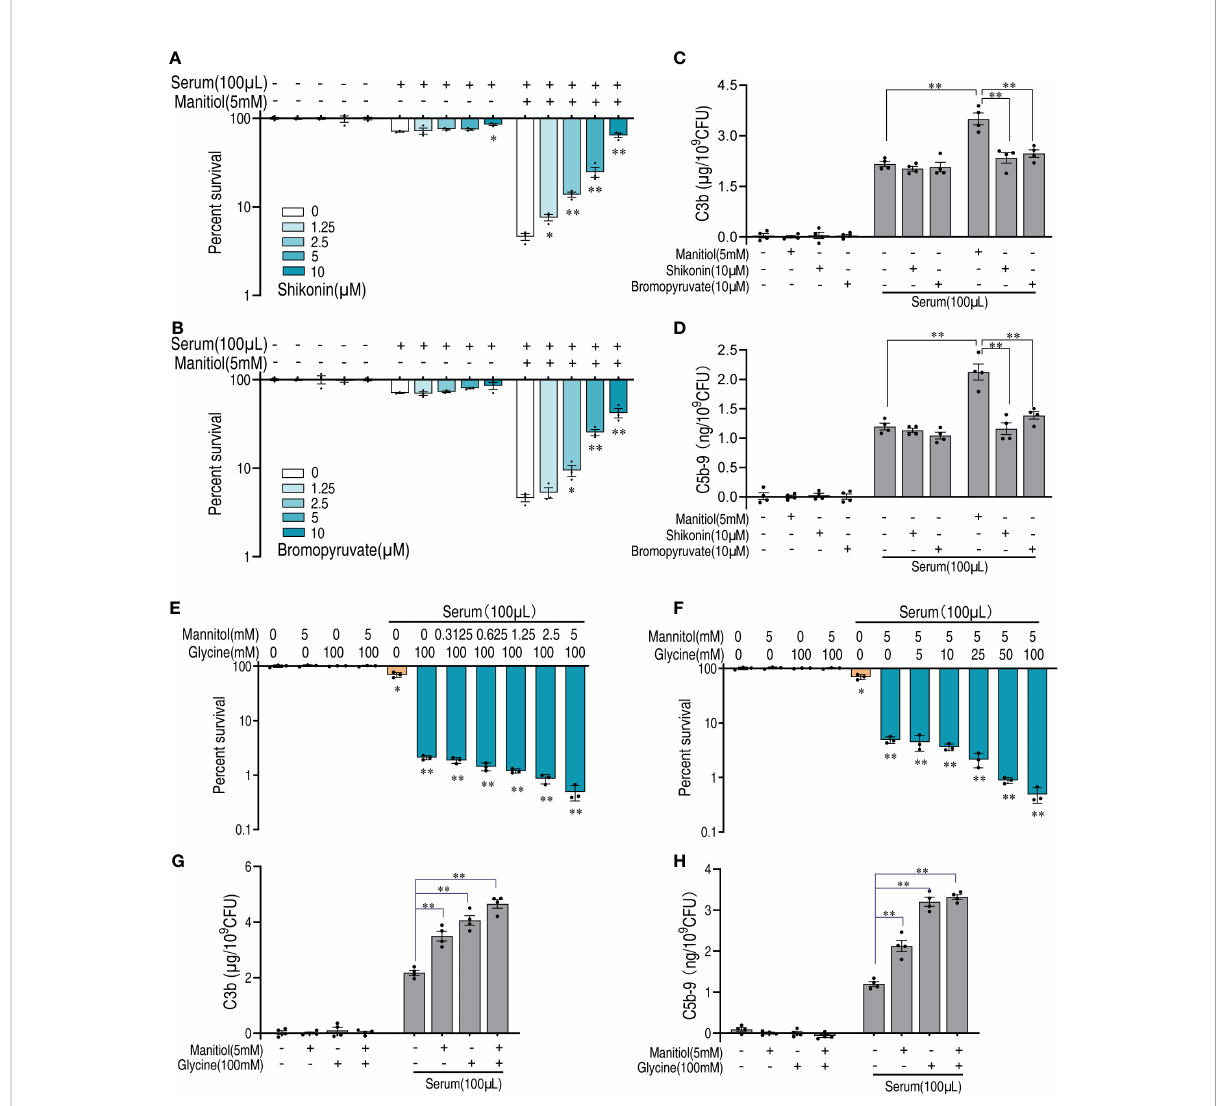
FIGURE 7 Mannitol increases serum sensitivity via glycolysis and the pyruvate cycle. (A, B) Percent survival of V. alginolyticus in the presence or absence of increasing doses of shikonin (A) or bromopyruvate (B) and in the presence of serum and/or mannitol. (C, D) Quanti fi cation of C3b (C) and C5b-9 (D) incubated with 10 m M shikonin or 10 m M bromopyruvate in the presence or absence of 100 m l serum alone or in the presence of or without mannitol (5 mM). (E) Percent survival of V. alginolyticus 12G01 incubated with 100 mM glycine plus serum (100 m l) in a mannitol dose-dependent manner (0 – 5 mM). (F) Percent survival of V. alginolyticus 12G01 incubated with 5 mM mannitol plus serum (100 m l) in a glycine dose-dependent manner (0 – 100 mM). (G, H) Quanti fi cation of C3b (G) and C5b-9 (H) incubated with 5 mM mannitol and/or 100 mM glycine in the presence or absence of 100 m l serum. The results are displayed as means ± SEM, and signi fi cant differences are identi fi ed (* p < 0.05 and ** p < 0.01) as determined by Student ’ s t -test. At least three biological repeats were carried